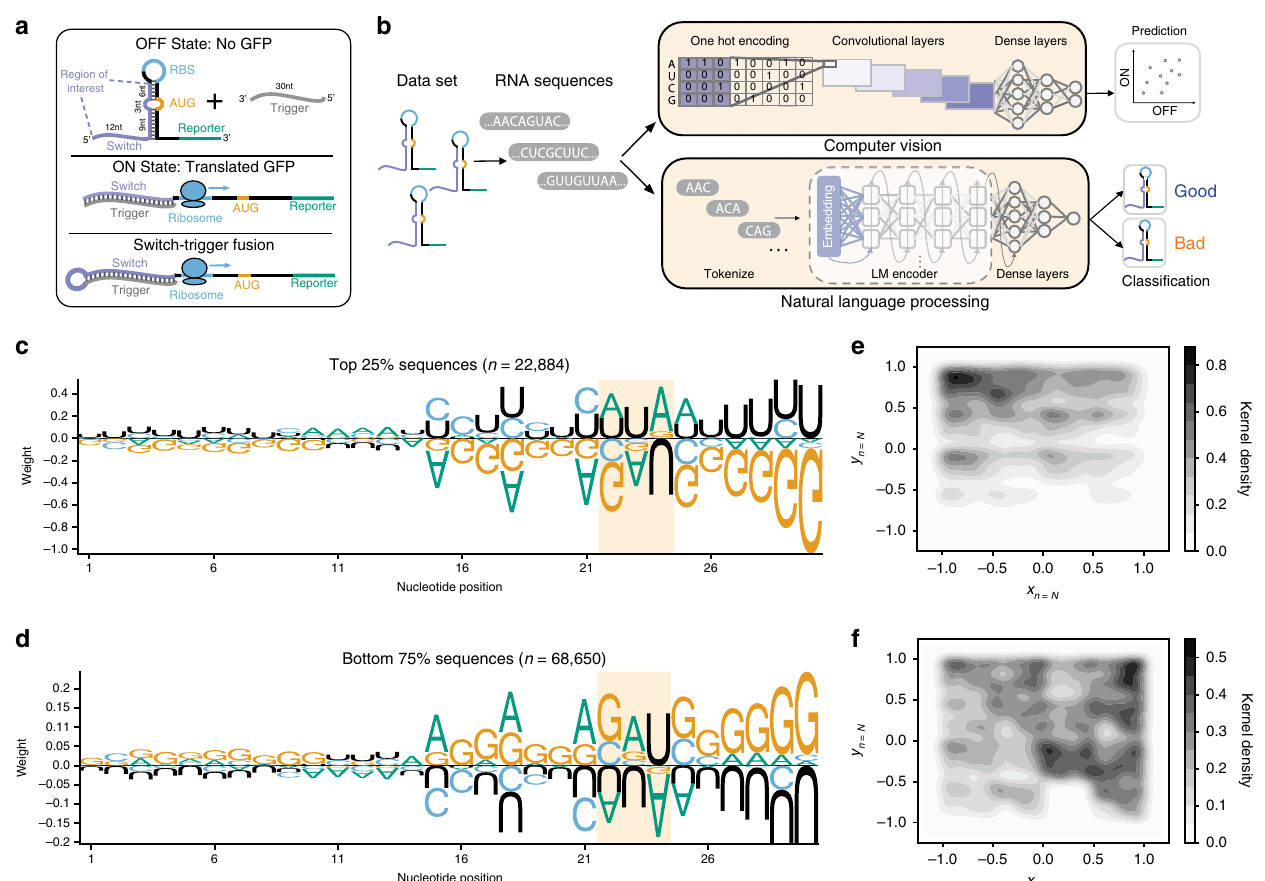
Fig. 1 Deep learning frameworks are needed to accurately stratify toehold switches. a Toehold switches modify their secondary structure in response to the presence of a complementary RNA molecule known as a trigger. In absence of the trigger, the Shine-Dalgarno sequence, or ribosome binding site (RBS), remains inaccessible and the reporter protein is not translated (OFF state). Upon binding of the trigger to the switch, the hairpin melts, allowing ribosome recruitment to the Shine – Dalgarno sequence and subsequent translation of the downstream reporter GFP protein (ON state). A modi fi ed ON state switch was built for experimental testing so that one molecule could be tested with trigger and switch fused together. b Two deep learning frameworks employing different strategies from computer vision and natural language processing were used to classify and predict toehold switch performance. c Sequence logos were calculated for the top 25% ( N = 22,884) and d bottom 75% ( N = 68,650) of sequences according to the experimental ON/OFF ratios. Weight corresponds to the log 2 of each nucleotide probability normalized by the background frequency of that nucleotide in the set of all experimentally tested toeholds. Highlight indicates the motif found in positions 22 – 24 (Supplementary Fig. S1). e Chaos-game-representations (CGR) for the top 25% ( N = 22,884) and f bottom 75% ( N = 68,650) of toehold switches were calculated to visualize macroscopic sequence patterns, where darker regions correspond to an enrichment of sequences in that CGR locus. The sequence logos, CGR plots, and biophysical properties (Supplementary Fig. S3), however, were insuf fi cient to characterize toehold performance on